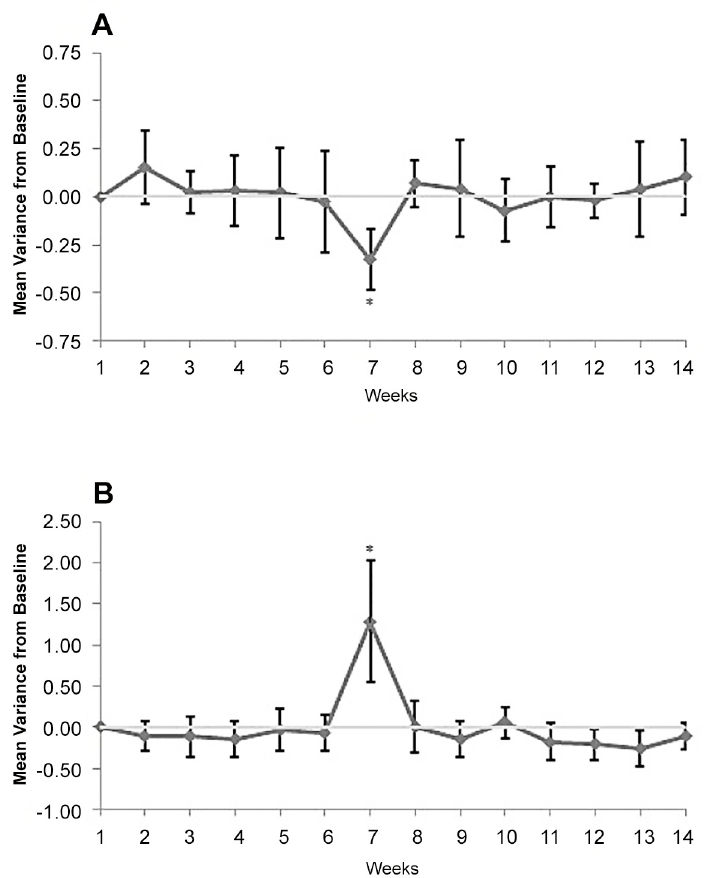
Fig 1. Percentage variance from the baseline (with 95% confidence interval) over the 14 week monitoring period for A) weekly heart rate variability, assessed by the standard deviation of short axis of the Poincare plot (SD1), and B) salivary alpha-amylase (sAA). * indicates very likely lower (A) or very likely higher (B) than baseline .